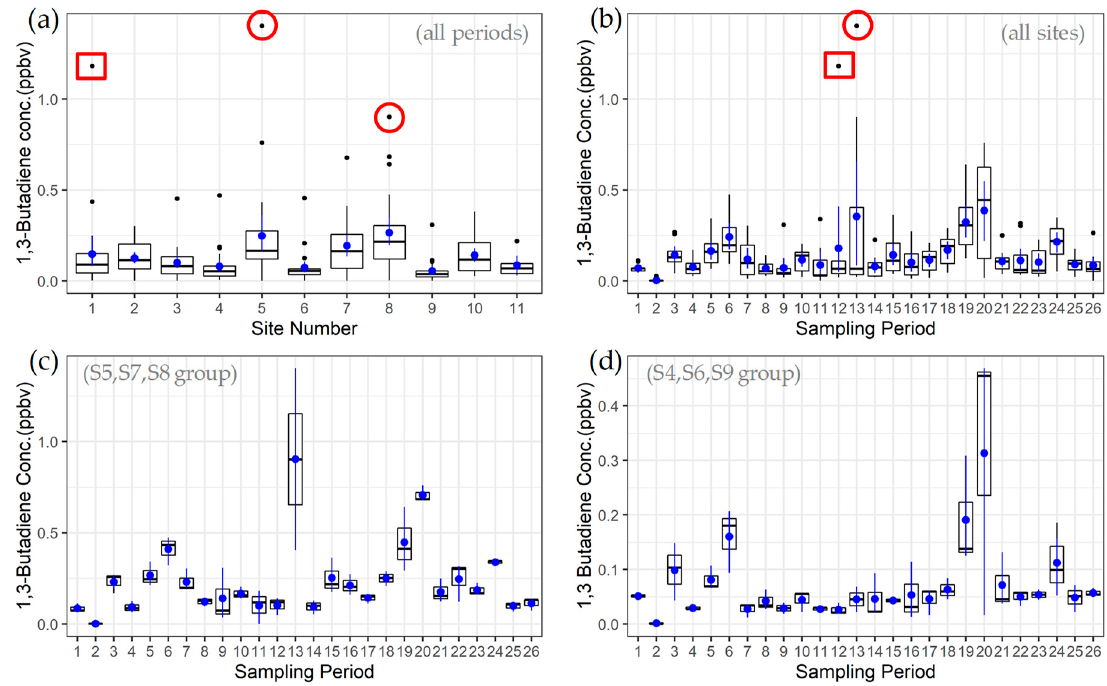
Figure 3. PS-determined 1,3-butadiene concentrations: ( a ) By monitoring site with all 26 PS sampling periods grouped [6 periods for S11], ( b ) by PS sampling period with all 10 monitoring sites grouped, ( c ) by period with three sites closest to 1-3 butadiene-relevant facilities grouped (near-facility group), and ( d ) by period with two farthest sites and an upwind site grouped (community / upwind group). The box whiskers extend to the largest measurement < 1.5 times the interquartile range. Blue markers indicate means with 95% confidence intervals calculated by non-parametric bootstrap. The red box and circles in ( a ) and ( b ) indicate the highest reading at S1 during period 12 and highest readings at S5 and S8 during period 13, respectively.